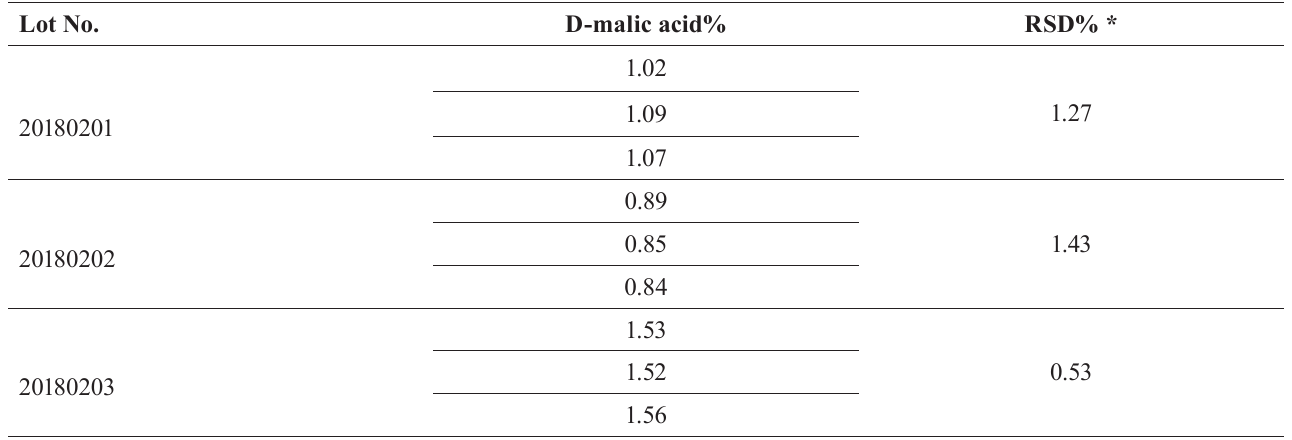
TABLE I - R esults of bulk drugs determination Lot